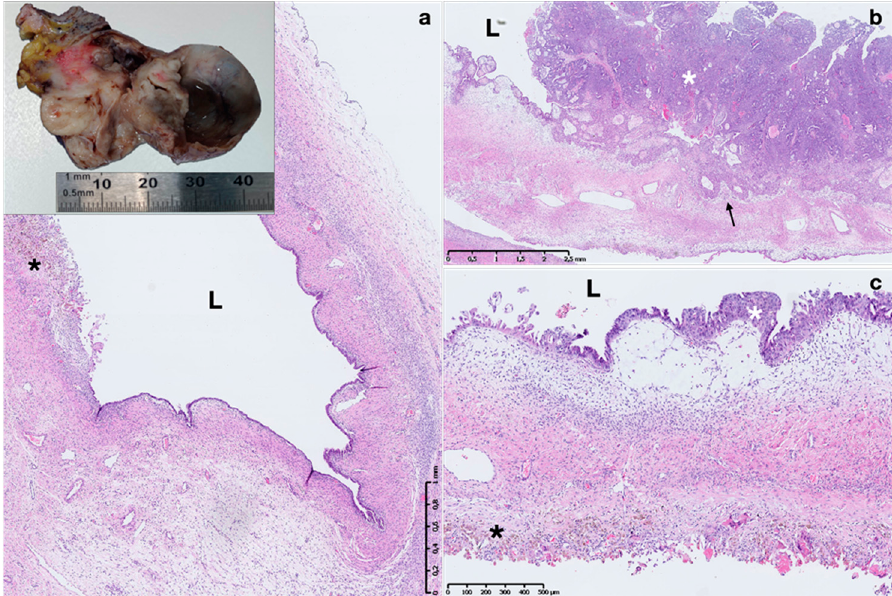
Figure 3. Macro- and micro-photograph of endometrioma with malignant transformation in endometroid carcinoma. A 4 cm endometrioma with cystic and solid components and a papillary lesion arising from the cyst wall ( a inset). Histopathological image of endometriotic cyst with wide lumen lined by a single layer of columnar epithelium without atypia surrounded by relatively scant stroma ( a ). Part of the cyst wall shows the eroded lining epithelium replaced by hemosiderin-laden macrophages (dark asterisk) ( a ) and part shows a proliferation of atypical glandular cells arranged in a papillary structure (white asterisk) and invading the stroma (arrow) ( b ). Higher-power view showing an atypical lining epithelium with hobnail cells, large vesiculated nuclei with prominent nucleoli, nuclear pleomorphism (white asterisk) ( c ). L: cyst lumen. Hematoxylin and eosin stain.